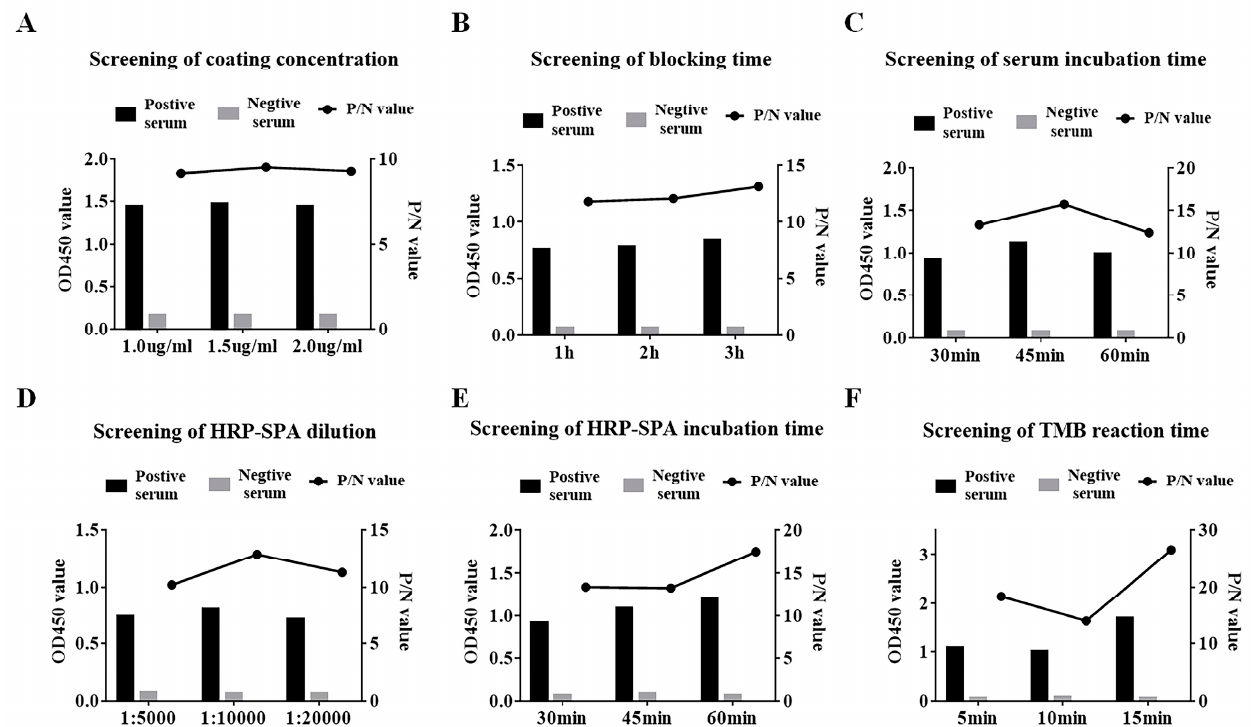
Figure 3. Optimization of ELISA reaction conditions. ( A ) Screening of coated antigen concentration. ( B ) Screening of blocking time. ( C ) Screening of serum incubation time. ( D ) Screening of HRP-SPA dilution. ( E ) Screening of HRP-SPA incubation time. ( F ) Screening of TMB reaction time. The left axis shows the absorbance of the data (OD 450 ) and the right axis shows the ratio of the positive control to the negative control (P/N value).